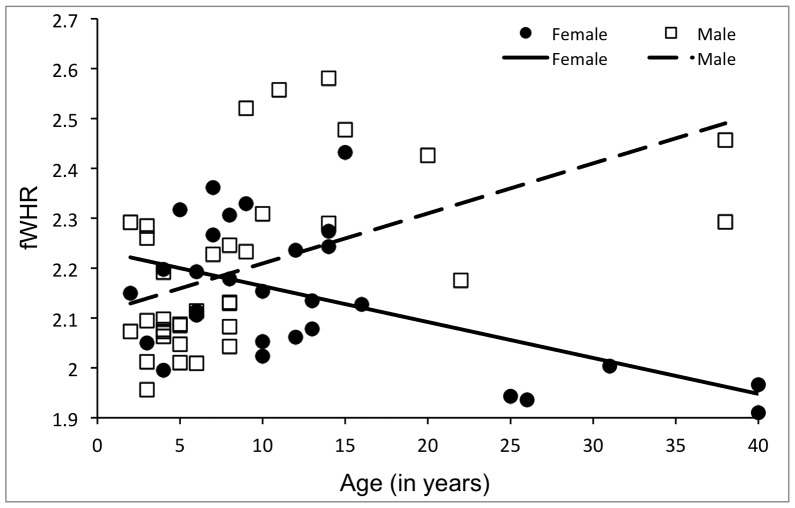
Linear effects of age and sex on fWHR.In males, fWHR increases significantly with age, suggesting developmental changes at puberty. In females, fWHR appears to decrease over the lifespan, although no significant change is observed when excluding animals older than 20 years.